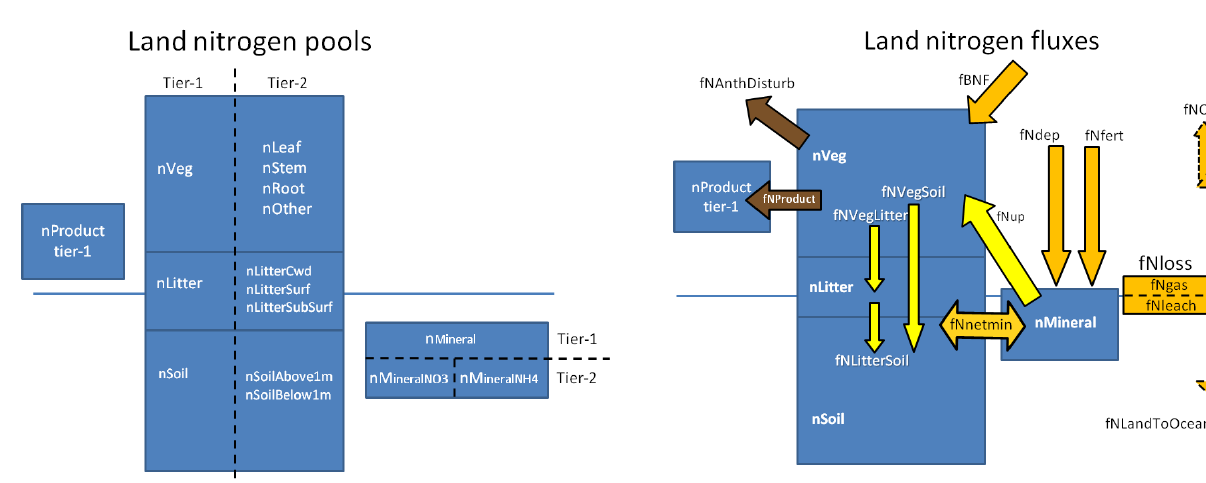
Figure 8. Requested tier-1 and tier-2 variables representing land nitrogen